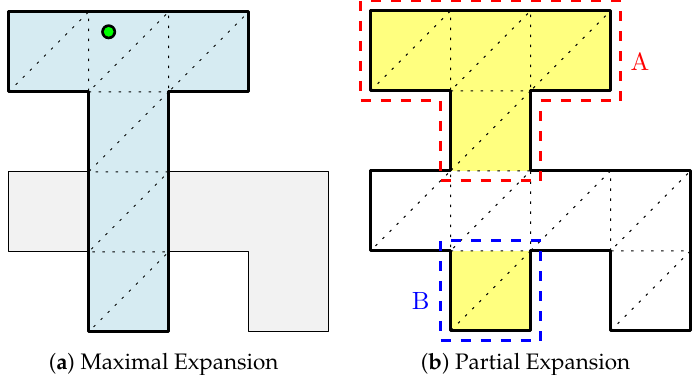
Figure 9. Illustration of connected partial expansion. ( a ) a seed facet (green dot) with its maximal expansion. ( b ) A is its connected partial expansion, while B is not because it does not contain the seed facet. Neither is A ∪ B , because it is